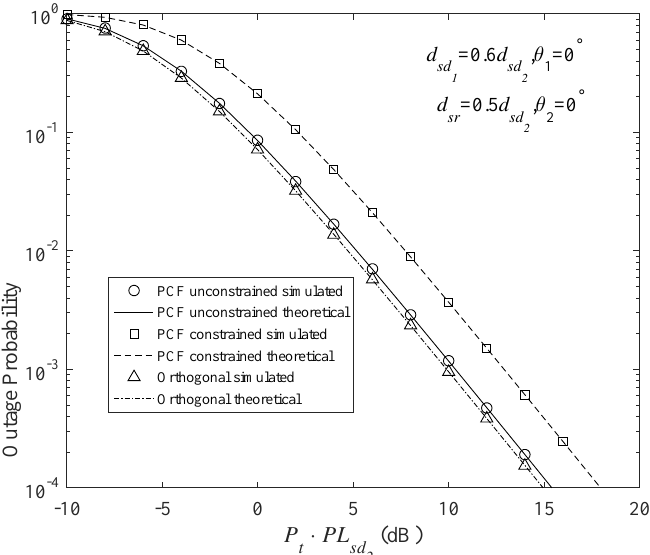
Figure 4. Outage probability of different DF protocols at N d τ 2 = 2 b/s/Hz for the orthogonal multiplexing), PCFs of the PCF-constrained protocol α = 0.5 α max and β = 0.5 α max , PCFs of the PCF-unconstrained protocol α = 0.9 α max and β = 0.5 α max , and transmit powers P r = P s .